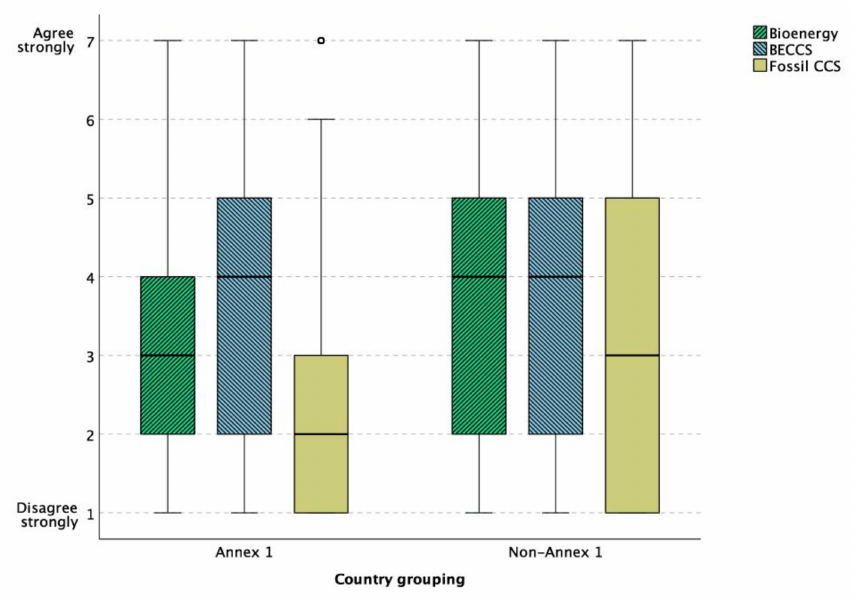
Figure 6. Level of agreement or disagreement by delegates residing in Annex 1 and non-Annex 1 countries that bioenergy, BECCS, and fossil CCS should receive investments in their